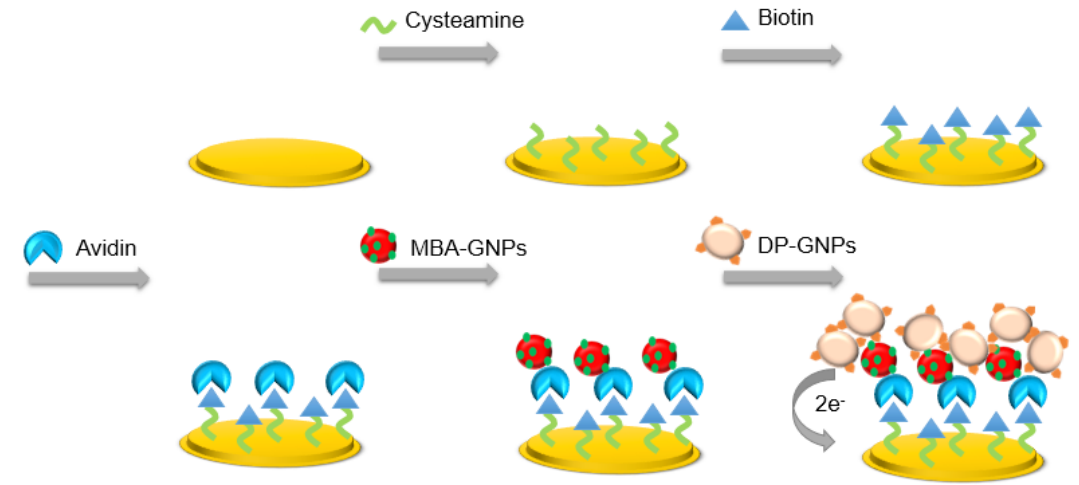
Figure 10: A scheme of the sandwich-type biotin-avidin detection based on dual amplification of MBA-GNPs and DA-GNPs. Reprinted from Biosensors and Bioelectronics, Copyright (2013), with permission from Elsevier [160]. Table 3: Summary of selected parameters of impedimetric biosensors.